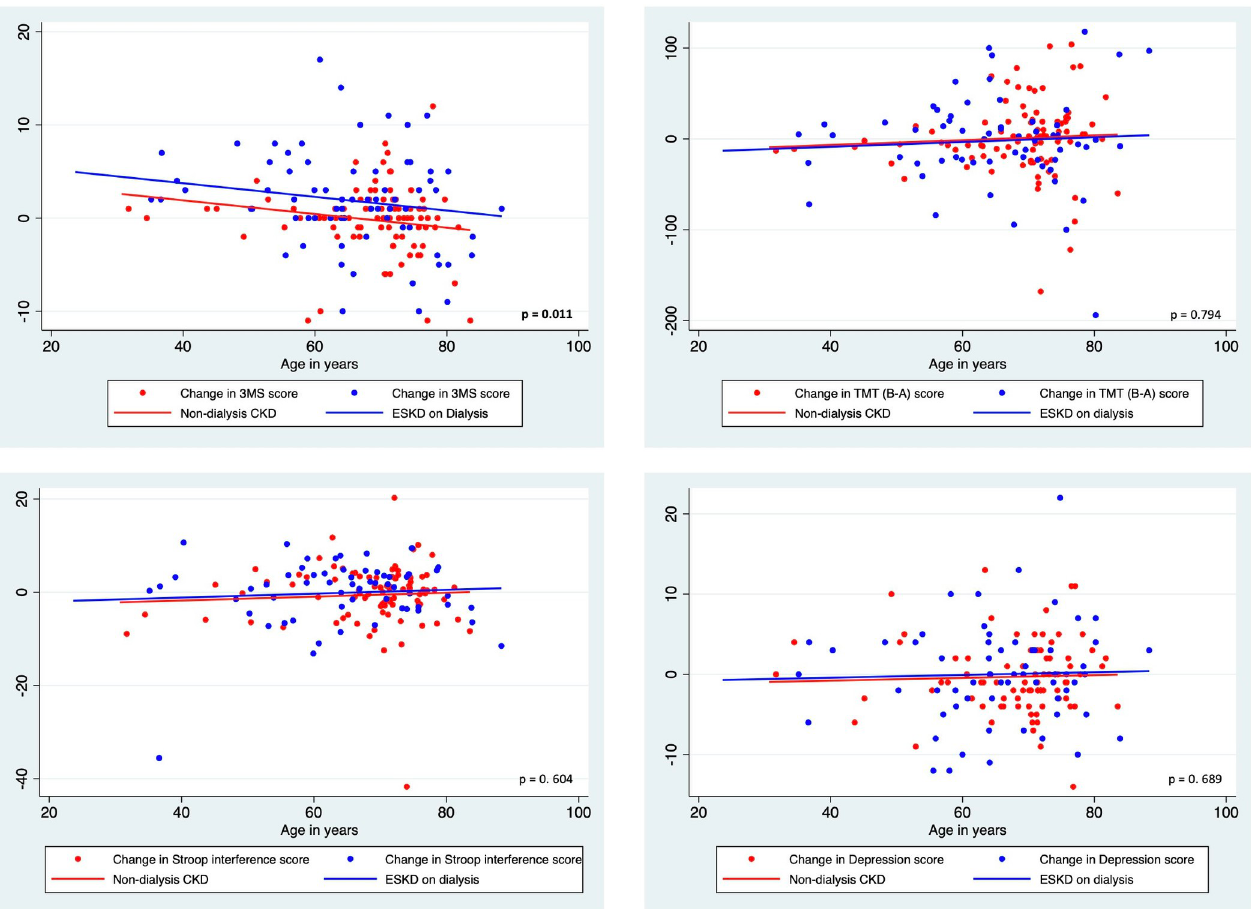
Fig 2. Change scores of cognitive function and depression in CKD and ESKD patients with fitted regression lines from ANCOVA models using age as a continuous covariate.